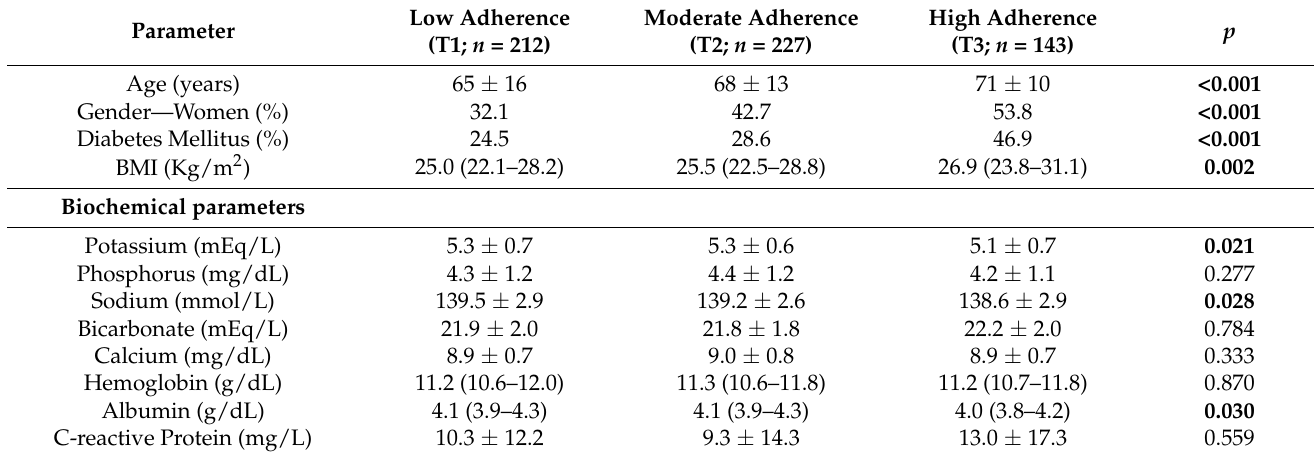
Figure 1. Correlation between serum potassium and dietary potassium intake (r = 0.08; p = 0.06). The mean Fung’s Dash Index was 23.9 ± 3.9. Of the whole sample, 36.4% of the patients presented low adherence to the DASH dietary pattern (0–22 points), 39.0% presented a moderate adherence (23–26 points), and 24.6% a high adherence ( ≥ 27 points). Compared to the lower adherence group, patients with a higher adherence to the DASH dietary pattern were older ( p < 0.005); presented lower serum potassium ( p = 0.021), serum sodium ( p = 0.001), albumin ( p = 0.030), energy intake ( p = 0.006), % of fat intake ( p = 0.001) and sodium intake ( p < 0.005); had a higher prevalence of diabetes (<0.001) and higher body mass index (BMI) ( p = 0.002); and had higher intakes of carbohydrates (%DEI) (<0.001), fiber (<0.001), potassium (<0.001), phosphorus (<0.001) and calcium ( p < 0.001) (Table 2). Table 2. Mean differences between terciles of adherence to the DASH dietary pattern.